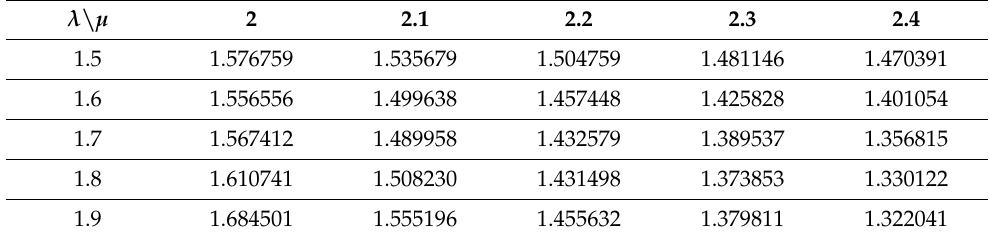
Table 1. Effect of λ vs µ on the waiting time of a customer in the queue ( Λ 3 ) . λ \ µ